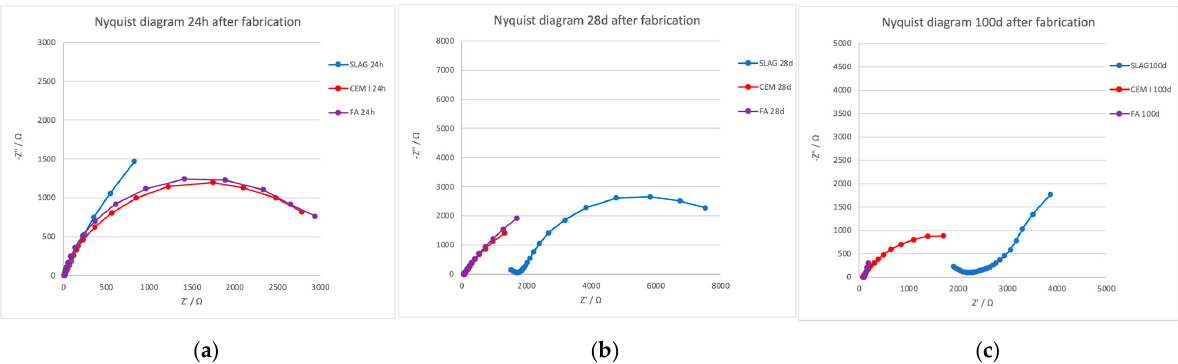
Figure 3. Nyquist diagrams obtained in the different mortars from early age up to 100 days after fabrication. Where Z’ is the real component and Z’’ is the imaginary component of the impedance vector. ( a ) 24h after fabrication; ( b ) 28 days after fabrication; ( c ) 100 days after fabrication. Table 6. Characteristic parameters obtained from de fitting of the Nyquist diagrams to a Randle equivalent circuit. Only one specimen per mortar type was tested.